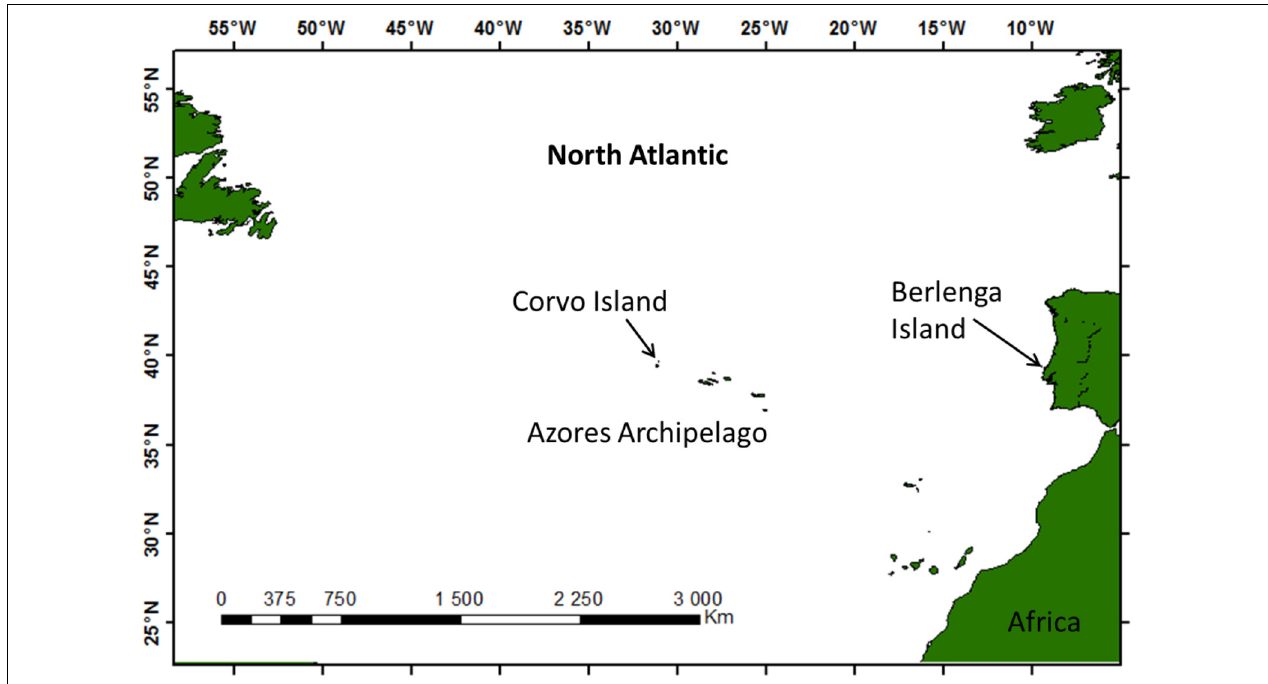
FIGURE 1 | Map of the North Atlantic showing the location of Berlenga and Corvo